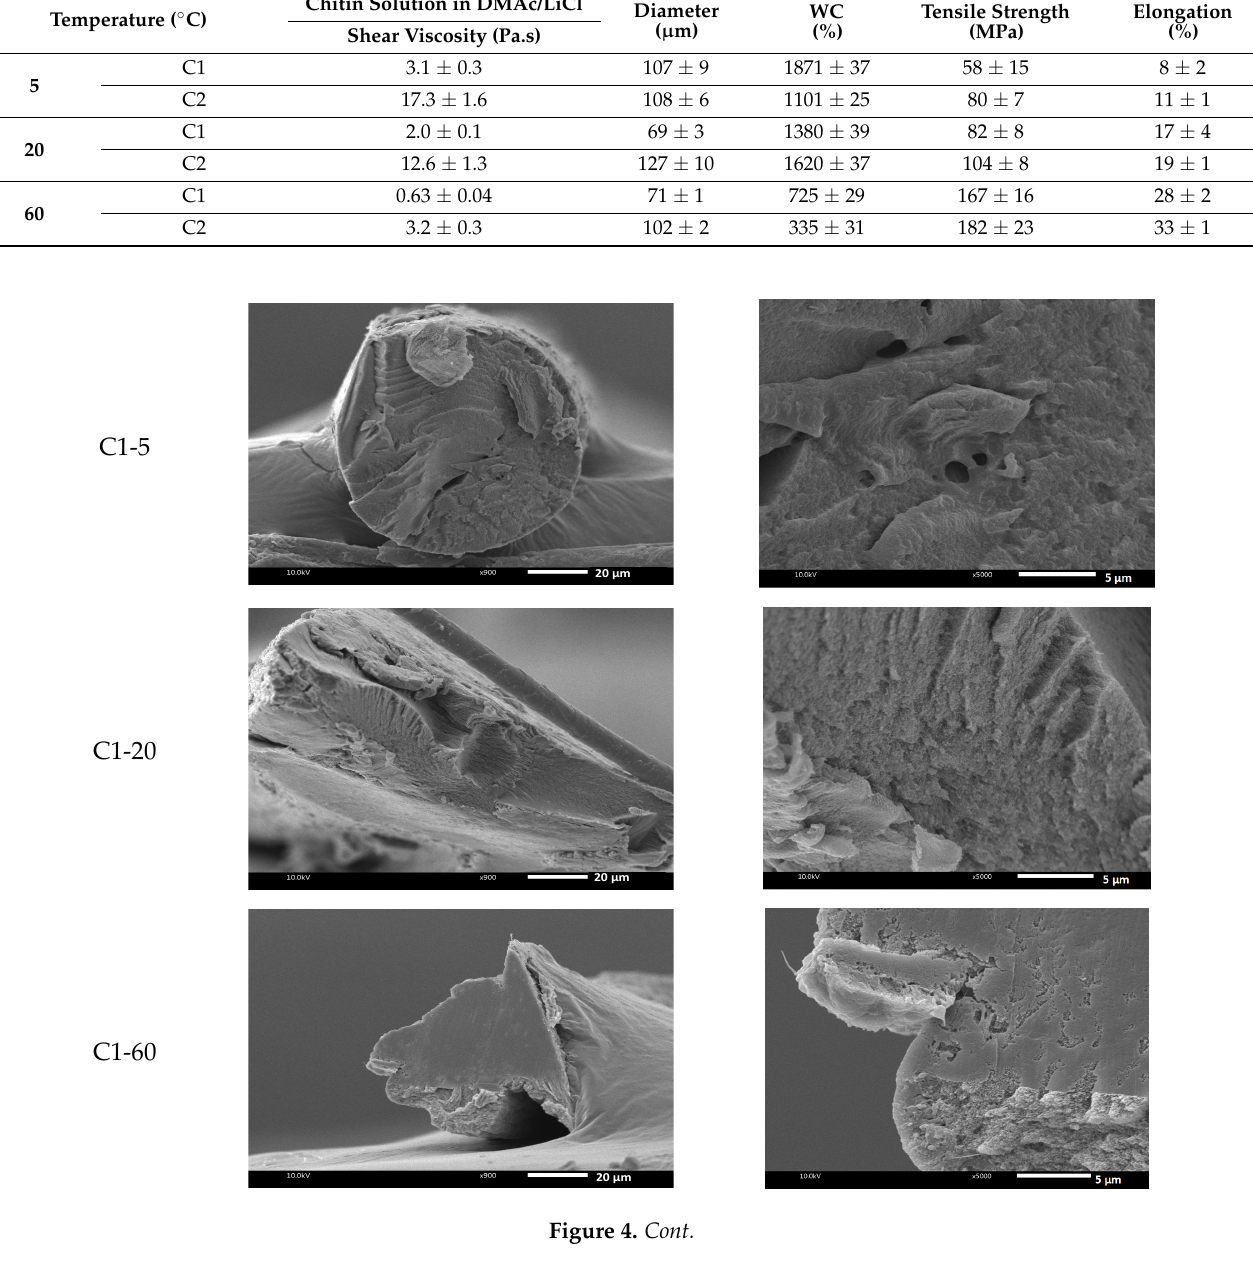
Table 1. Characteristics of chitin solutions and fiber prepared at different temperatures of the water coagulation bath. Chitin Solution in DMAc/LiCl Diameter Temperature ( ◦ C) ( µ m)